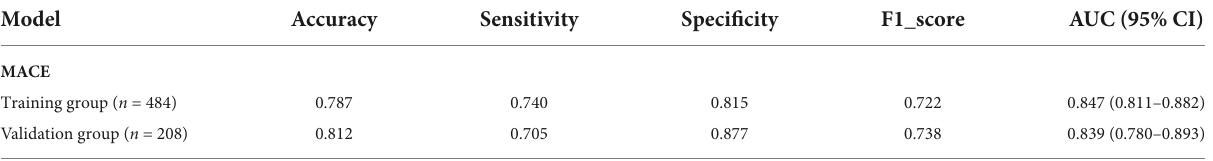
TABLE 4 Predictive value of nomogram in training group and validation